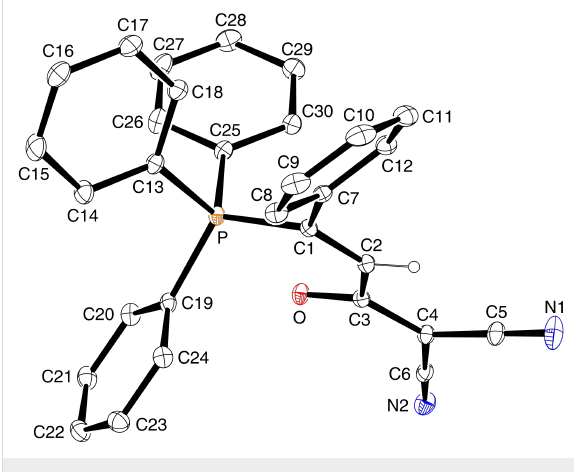
Figure 5: Solid-state structure of Z - 3e (ORTEP plot).